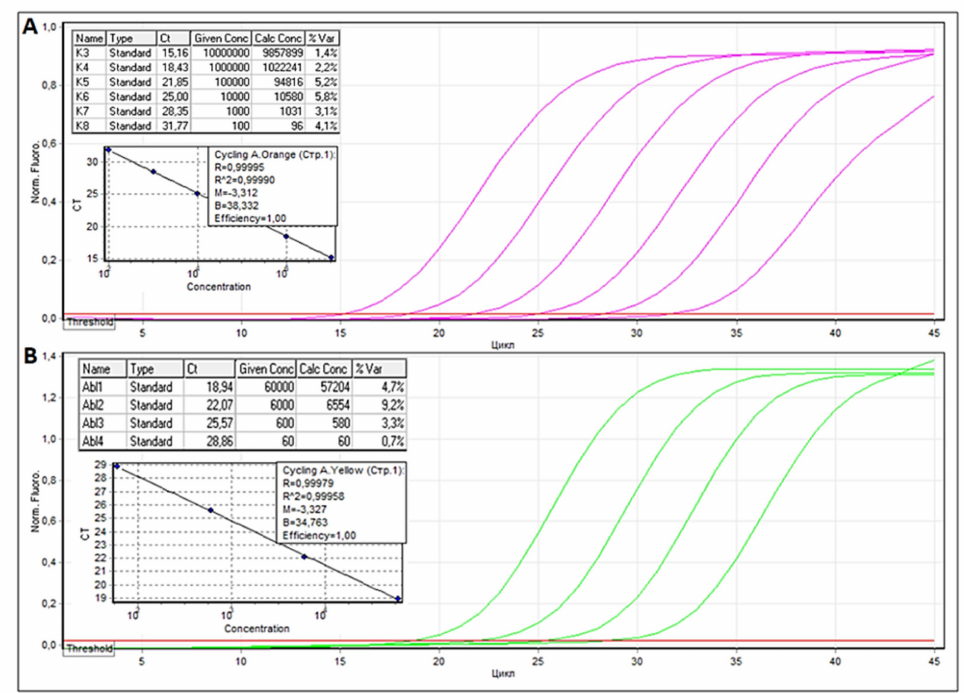
Figure 1. Threshold cycles and graphical RT qPCR curves for SARS-CoV-2 ( A ) and ABL1 ( B ) calibrator